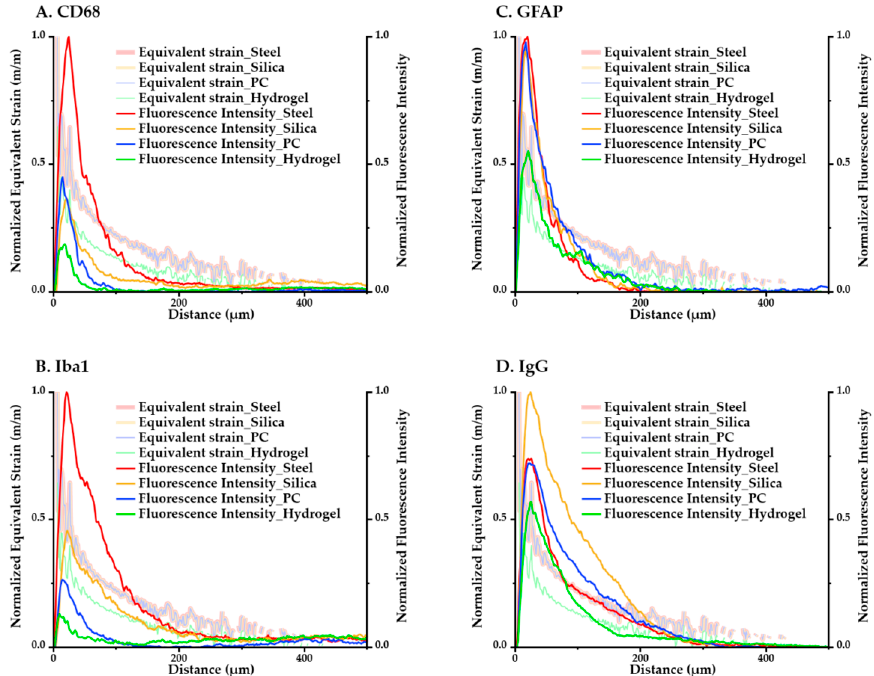
Figure 12. Overlay of min–max normalized equivalent strain plots and fluorescence intensity plots of each immune marker for all four kinds of materials. ( A ) CD68; ( B ) Iba1; ( C ) GFAP; ( D ) IgG.